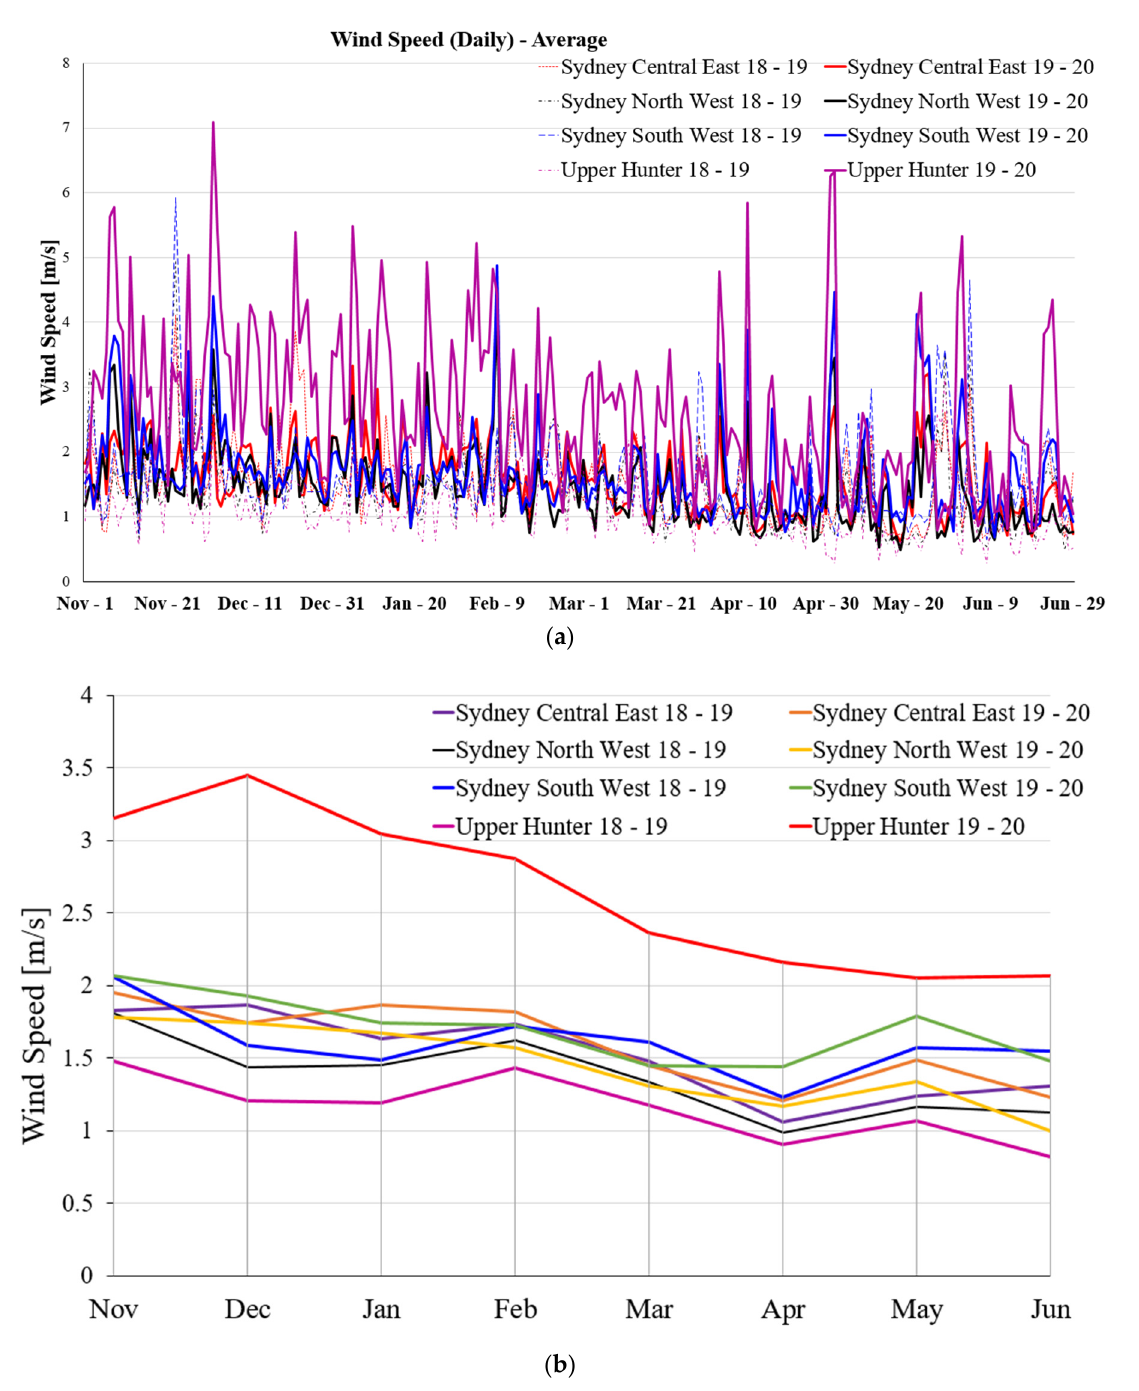
Figure 5. The average wind speed in Sydney Central East, North West, South West, and Upper Hunter region for a period of eight months during 2018–2019 and 2019–2020, ( a ) daily average wind speed, and ( b ) monthly average wind speed.